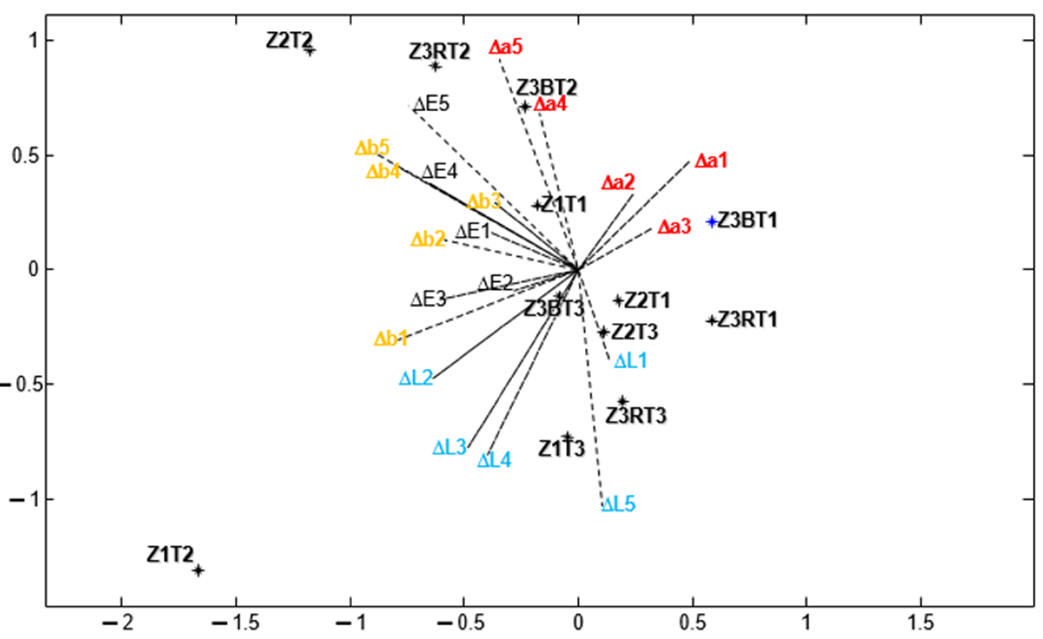
Figure 3. MANOVA-Biplot representation of the different Zamora building stones studied on the plane 1–2.